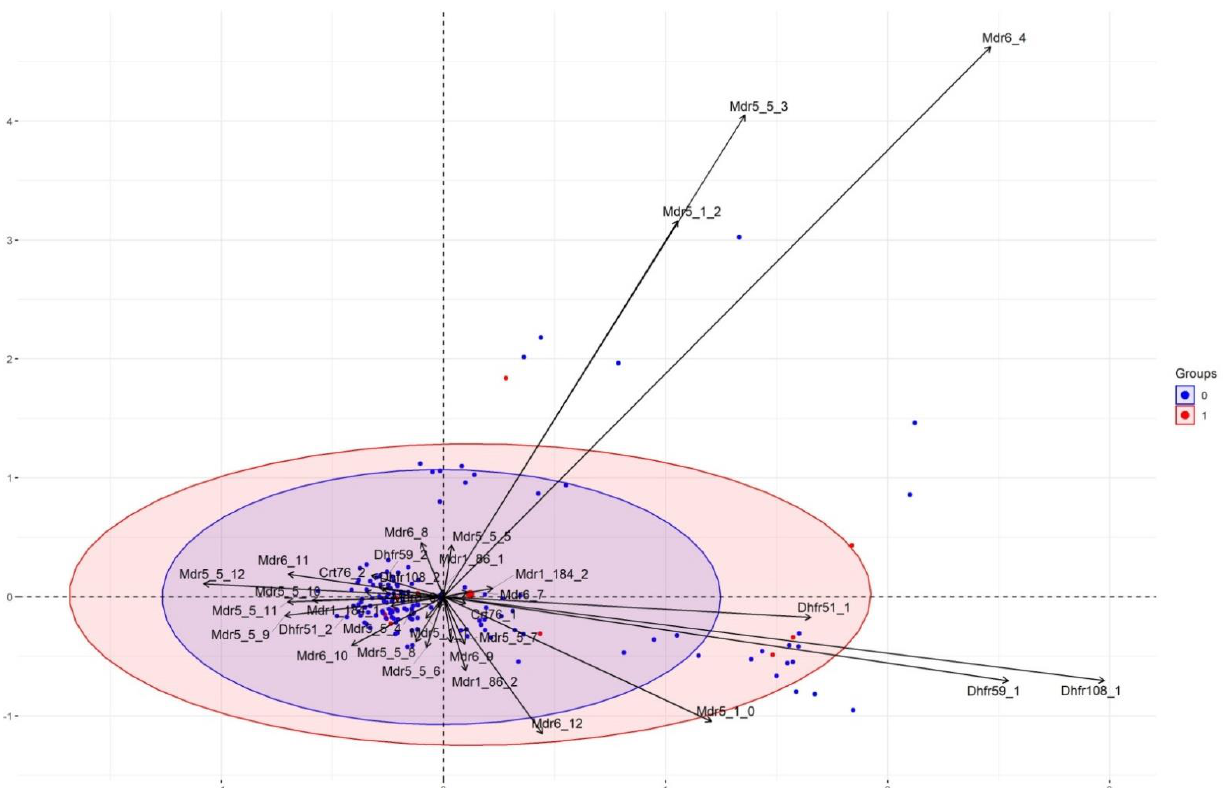
Figure 1. Multiple correspondence analysis biplot of Pfmdr5 , Pfmdr6 , Pfmdr1 , Pfcrt , and Pfdhfr gene polymorphisms in 271 African P. falciparum isolates (in blue parasites with IC 50 < 35 nM and in red parasites with IC 50 > 35 nM; Dhfr51_1 represents the haplotype N51 on Pfdhfr , Dhfr51_2 for 51I, Dhfr59_1 for C59, Dhfr59_R for 59R, Dhfr108_1 for S108, Dhfr108_2 for 108N, Mdr1_86_1 for N86, Mdr1_86_2 for 86Y, Mdr1_184_1 for Y184, Mdr1_184_2 for 184F, Crt76_1 for CVMNK, Crt76_2 for CVIET, Mdr5_x_y, x as pattern R1 and y as pattern R2, Mdr6_z, z as Asn repeat